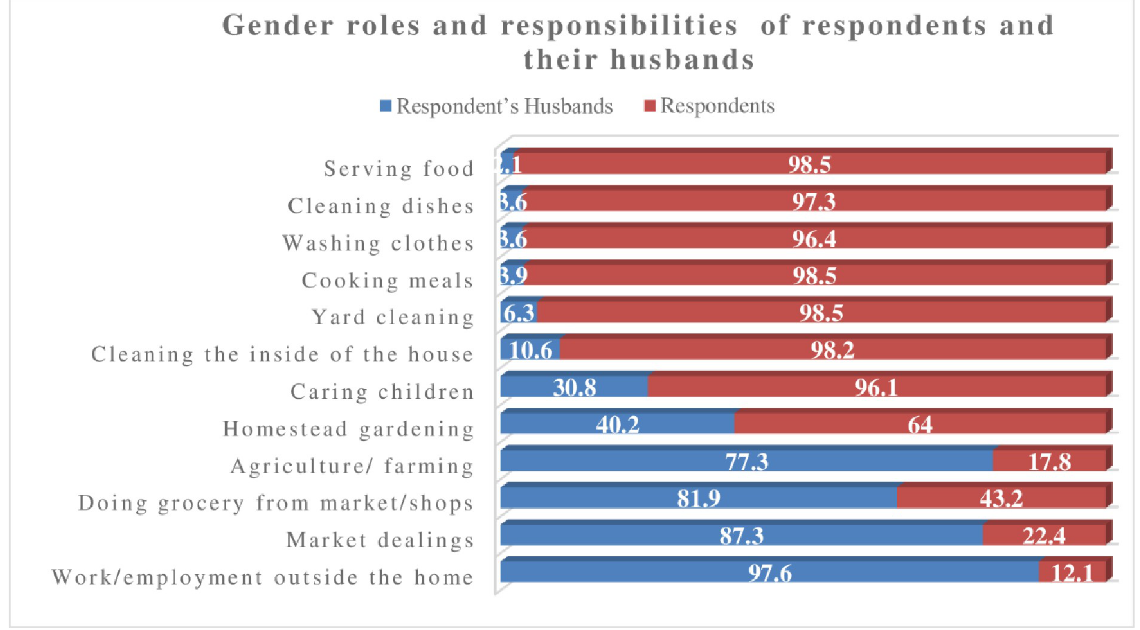
Fig 4. Household gender role and responsibilities of the respondents and their